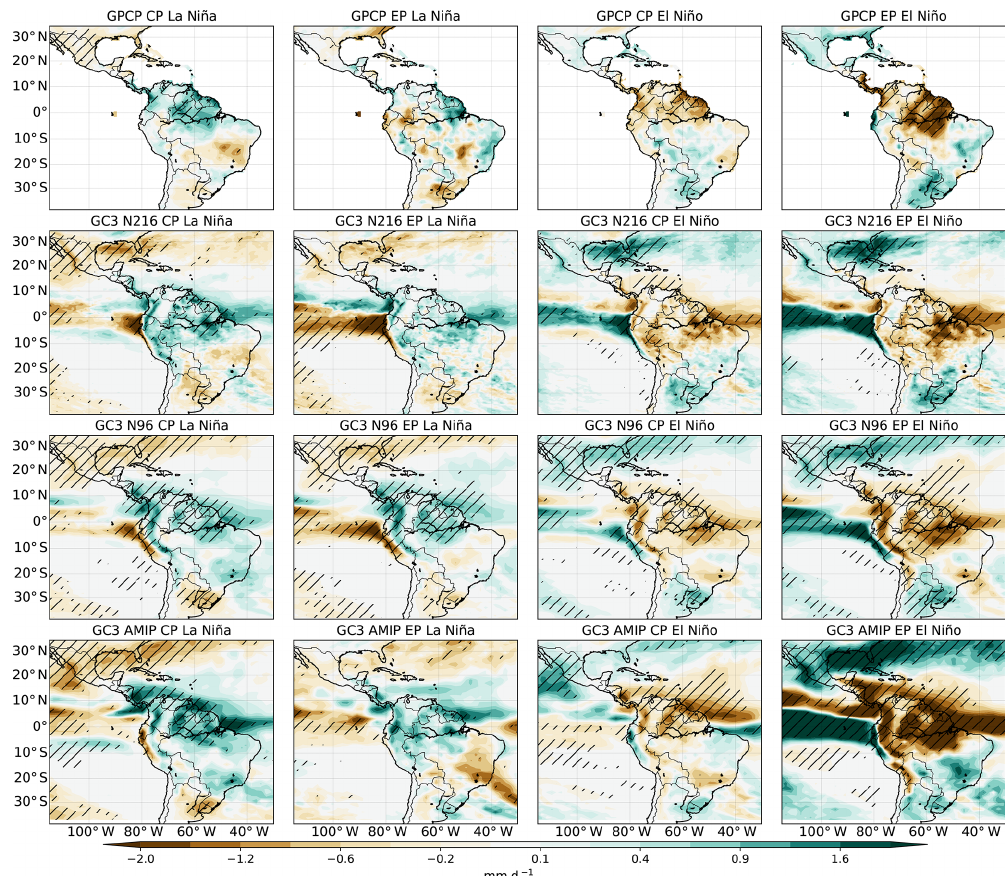
Figure 13. Precipitation anomalies in GPCC 1940–2013, GC3 N216, GC3 N96-pi and GC3 AMIP for the four different types of ENSO events, as defined by Cai et al. (2020). Statistically significant anomalies (95% confidence level) are hatched.